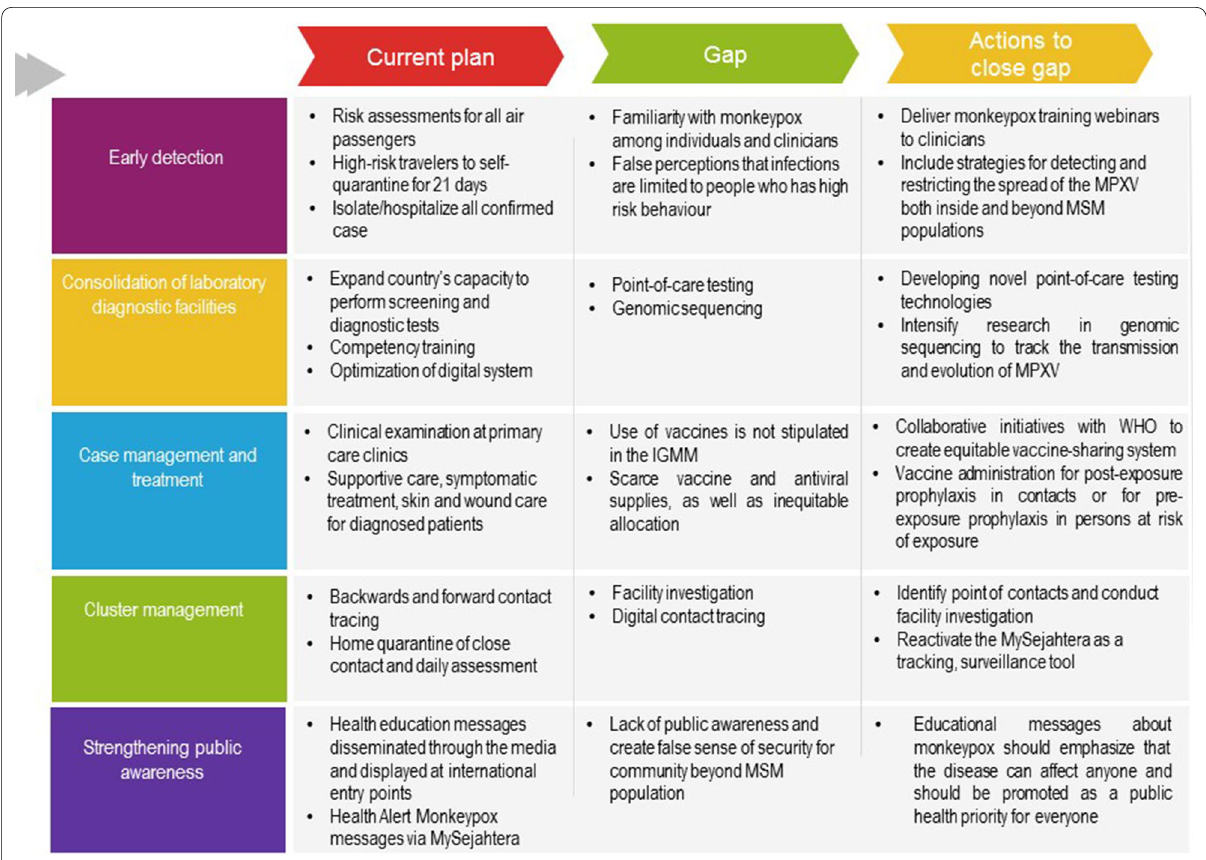
Fig. 1 Five pillars in control and containment monkeypox outbreak: current plan, gap and action to close